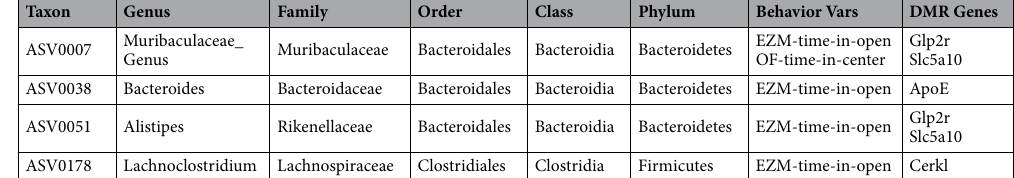
Table 2. ASVs that had significant associations with both behavior variables and percent methylation of